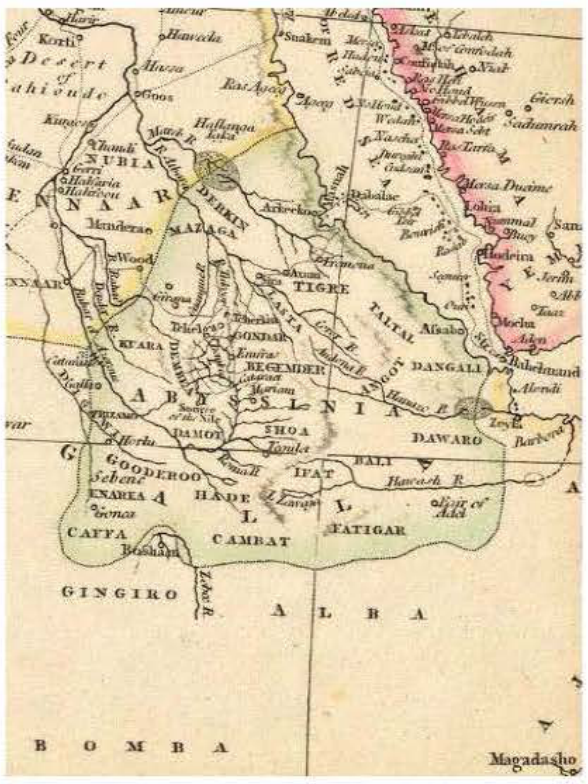
Figure 6: Arrowsmith Abyssinia (detail). Arrowsmith , Aaron (1808). "Map of the World on a Globular Projection ", first published 1794. London: A.